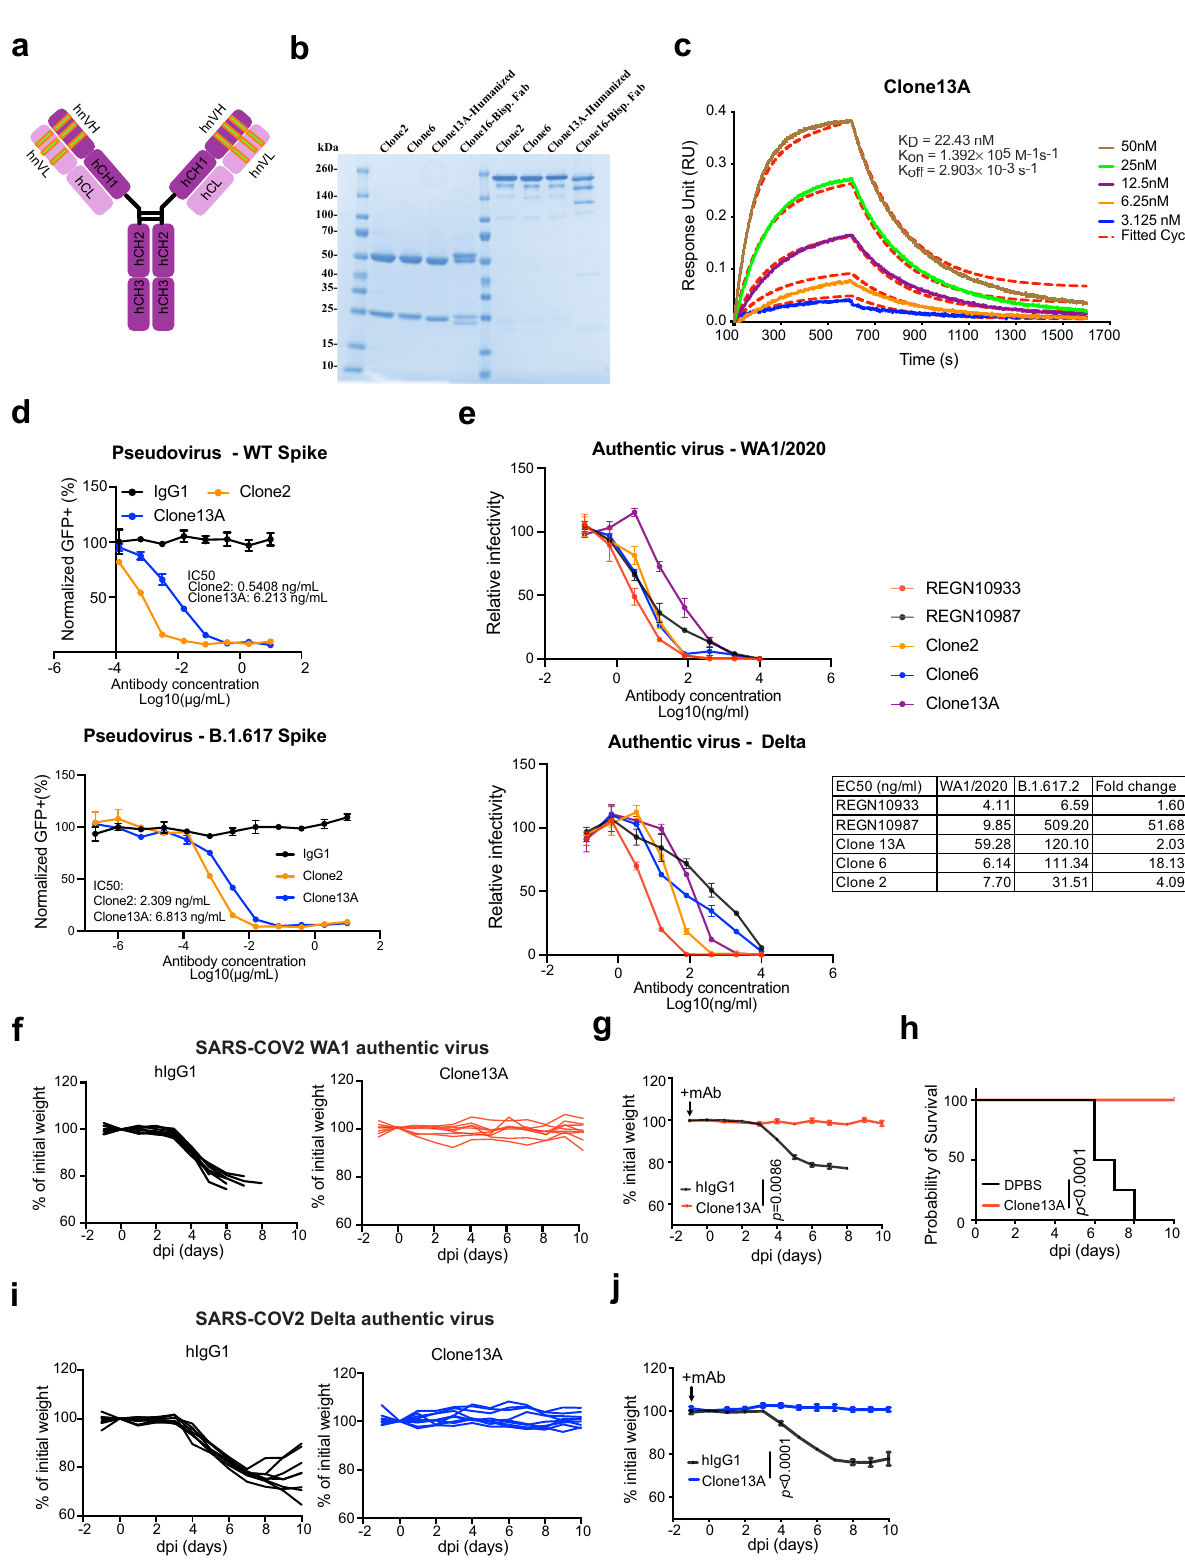
NsiI and NheI restriction enzymes digested pFUSEss-CHIg-hG1 backbone by the Gibson assembly (NEB). The pFUSE2ss-HoleLight-hK was generated by replacing the constant region of light chain (CL) in pFUSE2ss-CLIg-hK with CH1 region of heavy chain in pFUSEss-CHIg-hG1 vector. The CH1 region were PCR ampli fi ed from pFUSEss-CHIg-hG1vectors with a forward primer (oPR81-F) and a reverse primer (oPR82-R) containing regions overlapping with corresponding fl anking sequences of the NcoI and NheI restriction sites in the pFUSE2ss-CLIg-hK. CH1